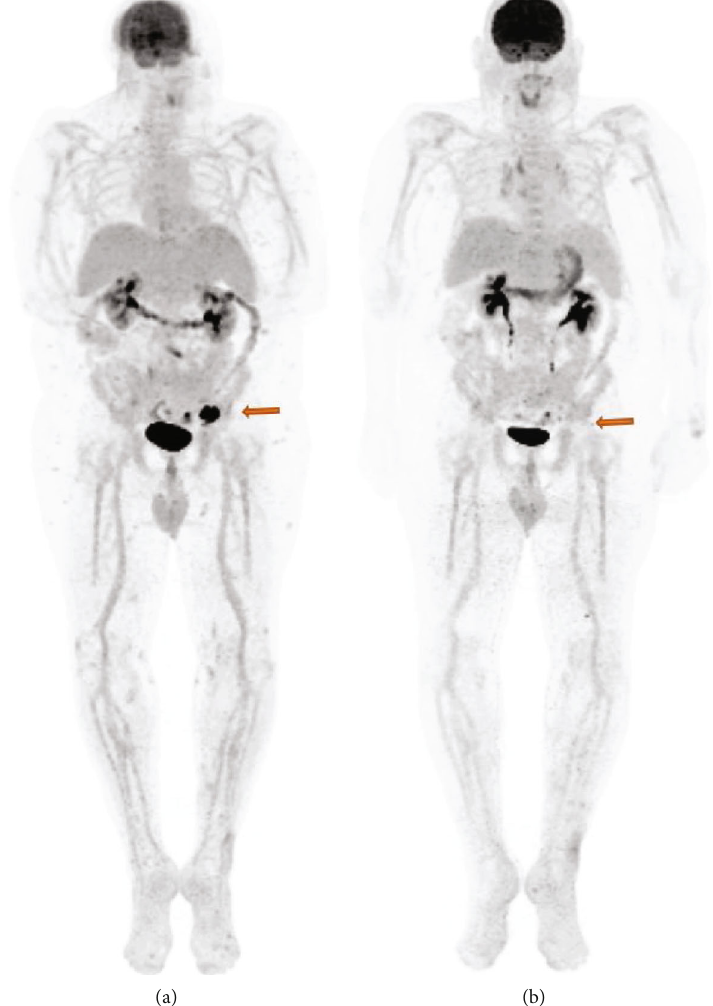
Figure 2: (a) PET/CT scan prior to start of ipilimumab/nivolumab immunotherapy showing FDG avid 2 : 8 × 3 : 9cm left inguinal lymphadenopathy. (b) PET/CT scan 4 months after reinitiation of ipilimumab/nivolumab immunotherapy showing near-complete resolution of the left iliac